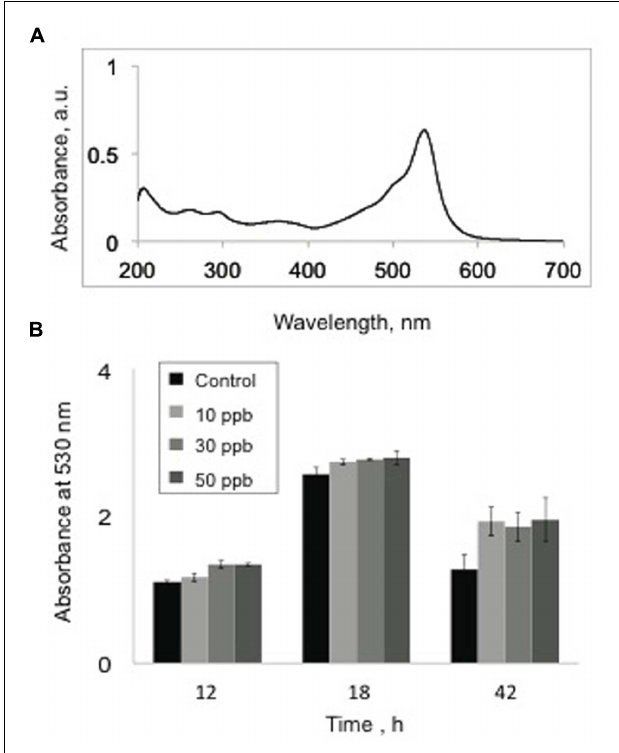
FIGURE 2 | Effect of aflatoxin B 1 exposure on prodigiosin production. (A) UV-Vis spectral profile of a prodigiosin-rich metabolite fraction demonstrating peak absorbance at 530 nm. (B) Comparison of absorbance values at 530 nm, of methanol extracts from untreated V. gazogenes cultures and cultures were supplemented with 10, 30, and 50 ppb of aflatoxin B 1 . Statistical significance of two-tailed p -values were determined using an unpaired t -test, with n = 3, and p < 0.05 as significance